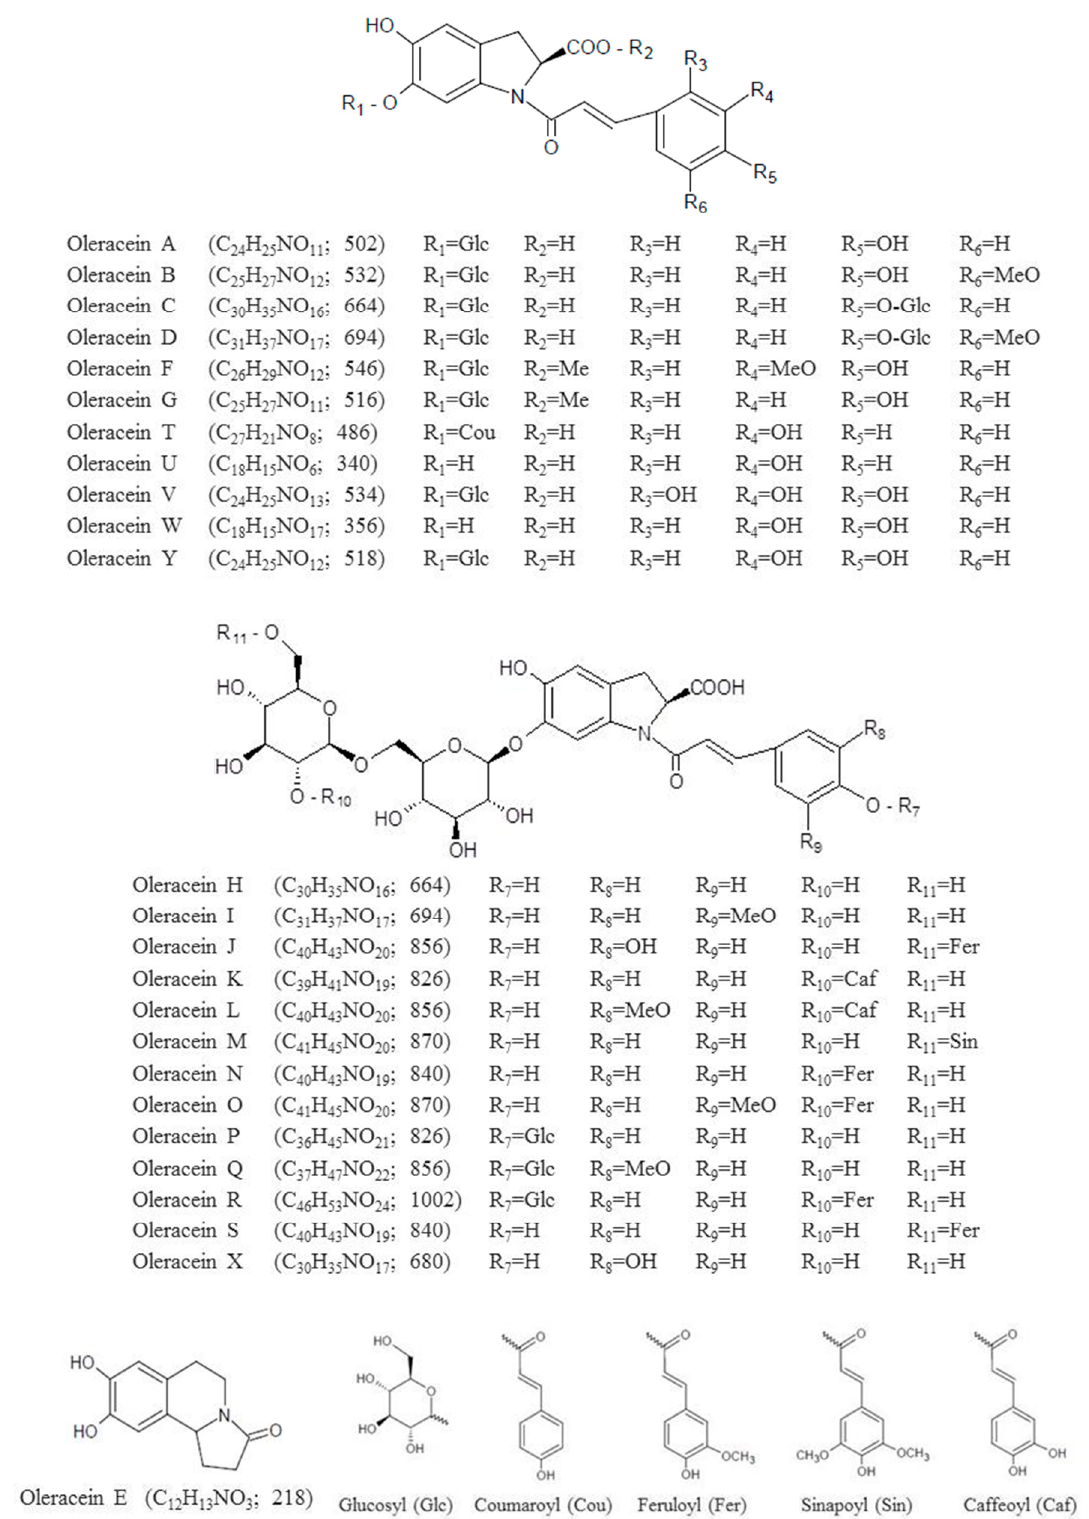
Figure 5. Chemical structures and molecular ions [M-H] − of oleraceins A-Y.